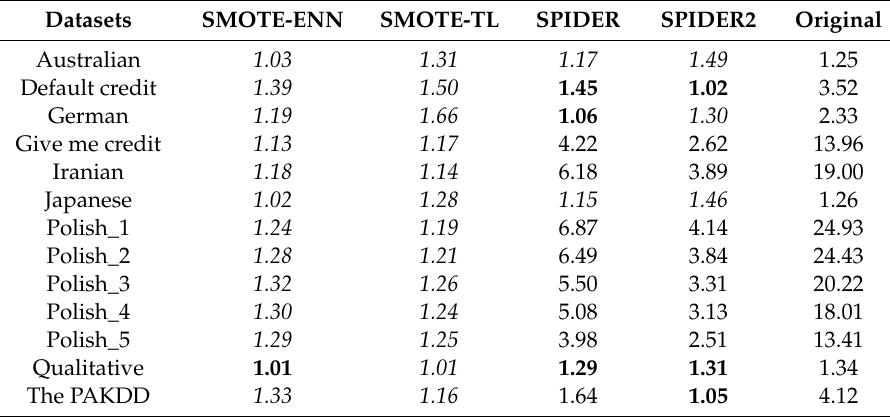
Table 8. Imbalance ratio for hybrid